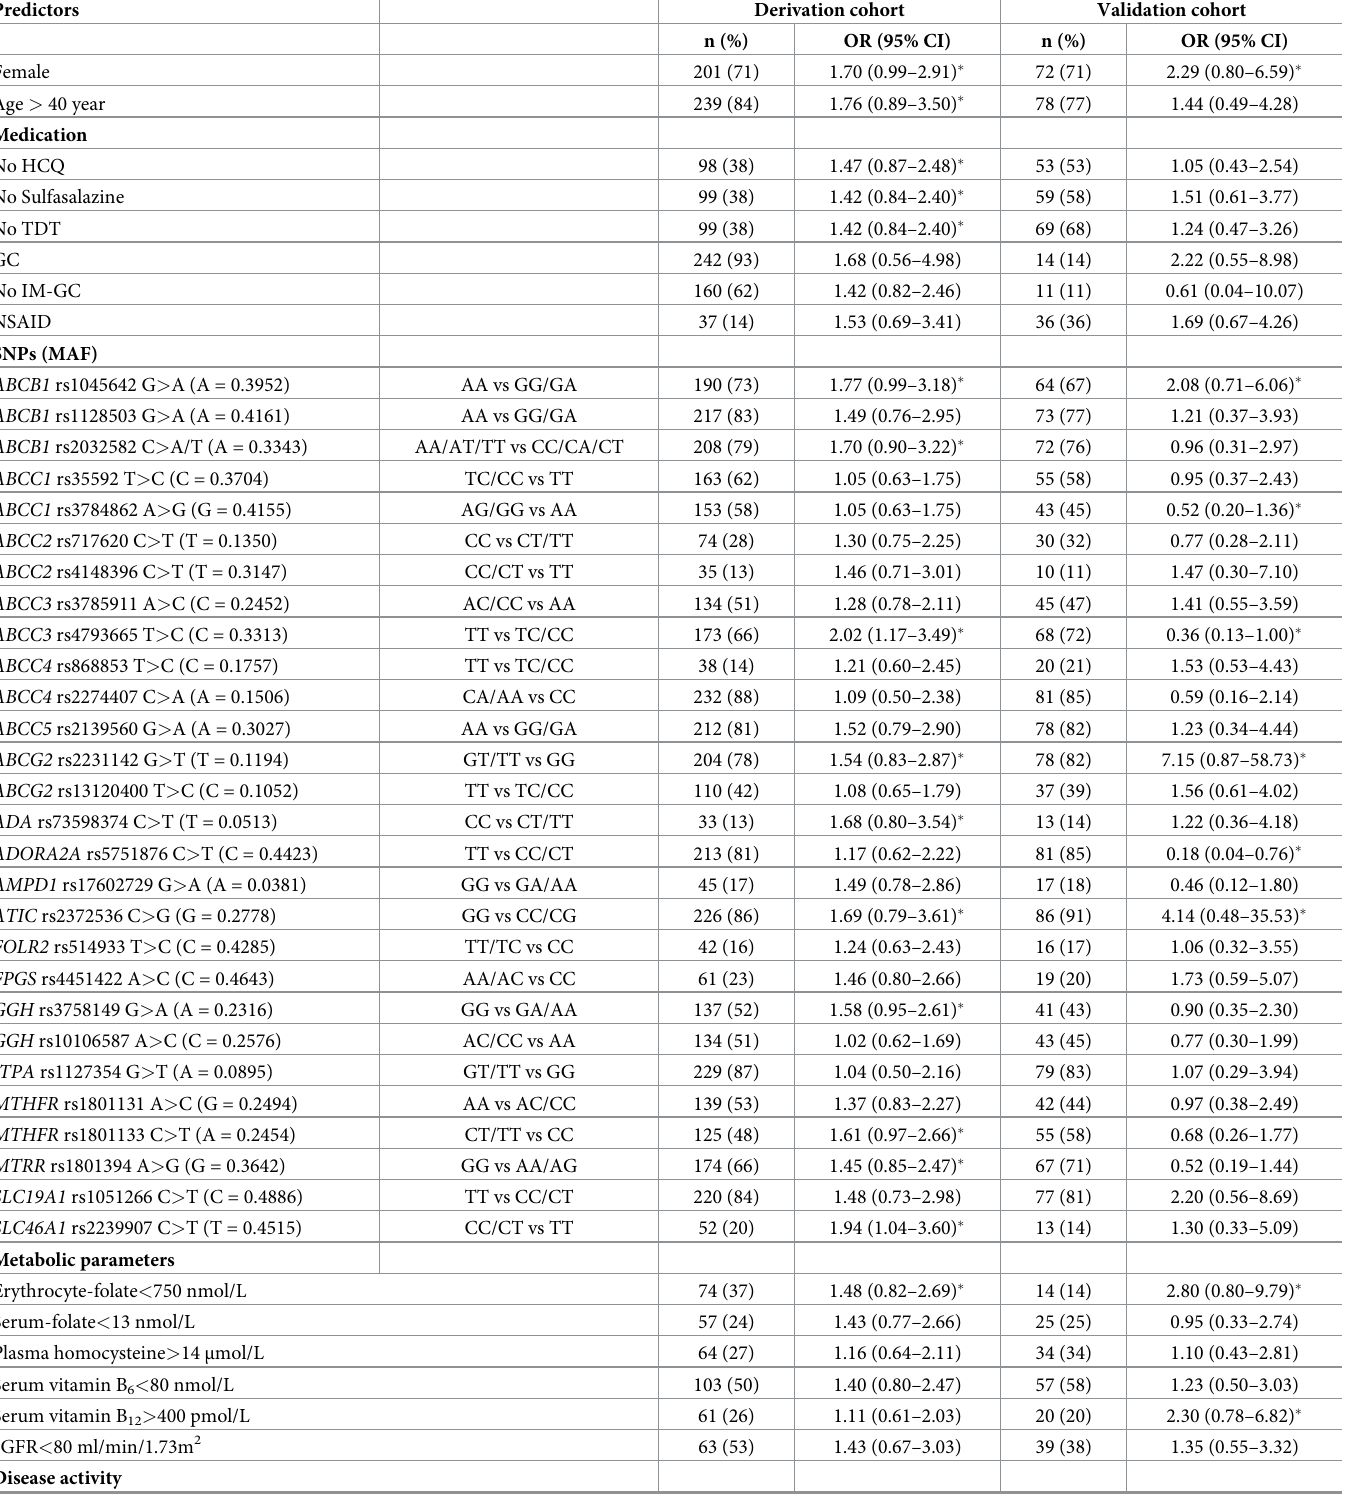
Table 2. Prevalencey, univariable OR’s (95% CI) for potential predictors of 3 months DAS28 > 3.2 insufficient response for derivation and validation